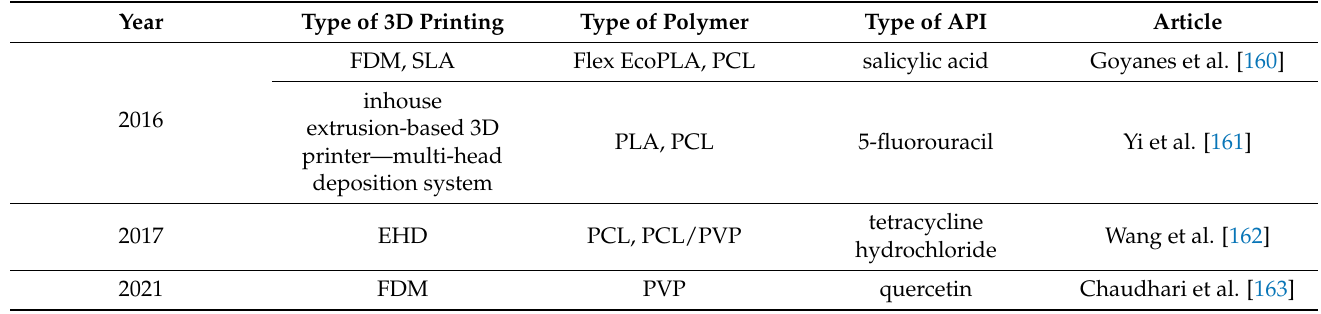
Table 6. The grouping of some manufactured TTSs based on the publication year and then in alphabetical